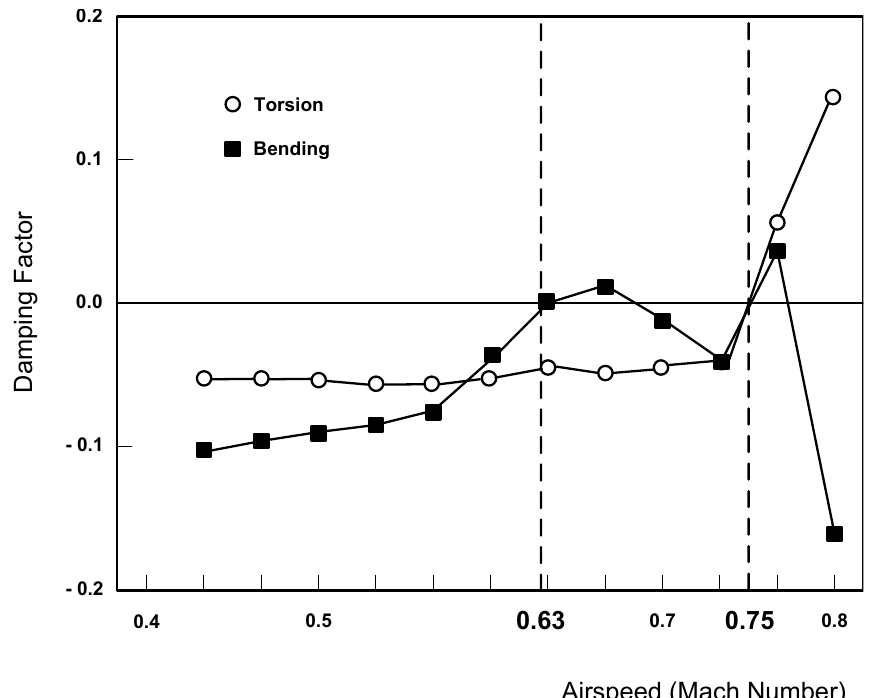
Figure 11. Calculated damping factor versus airspeed for the two modes of